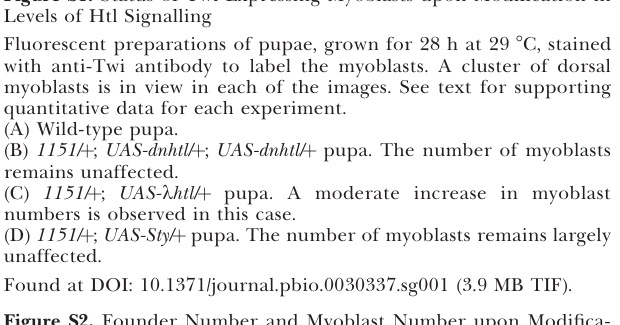
Figure S1. Status of Twi-Expressing Myoblasts upon Modification in Levels of Htl Signalling